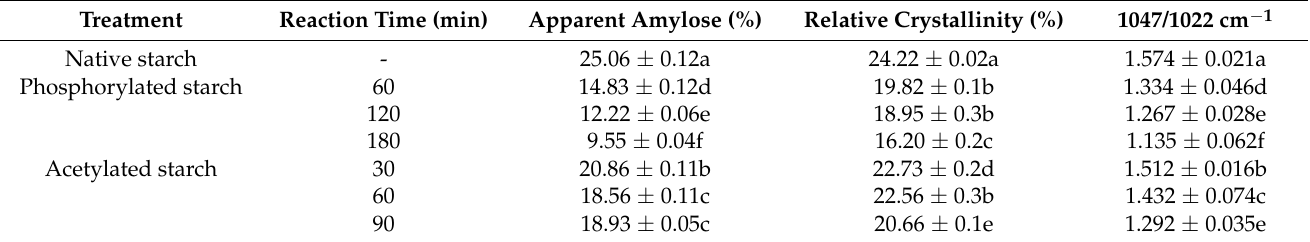
Values are means ± SD. Values with the same letters in the same column are not significantly different ( p < 0.05). NS: native chestnut starch; PCS-1: chestnut starch phosphorylated for 60 min; PCS-2: chestnut starch phospho- rylated for 120 min; PCS-3: chestnut starch phosphorylated for 180 min; ACS-1: chestnut starch acetylated for 30 min; ACS-2: chestnut starch acetylated for 60 min; ACS-3: chestnut starch acetylated for 90